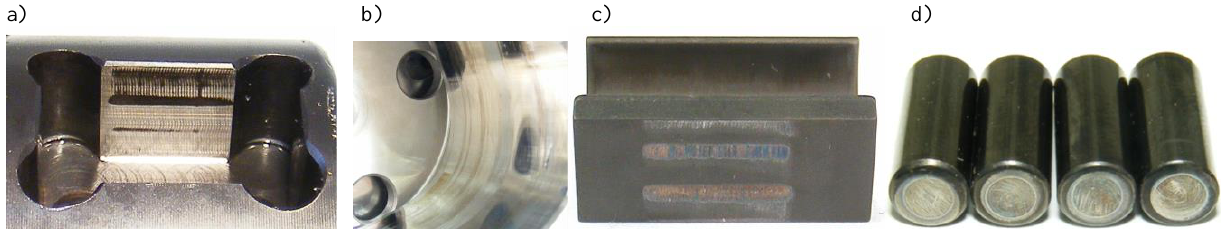
Fig. 5. Traces of abrasive or fretting damage observed on the working surface of high-pressure pump components: a) side guiding walls of follower seats in the pump body, b) raceway of internal cam ring, c) side follower walls, d) front piston